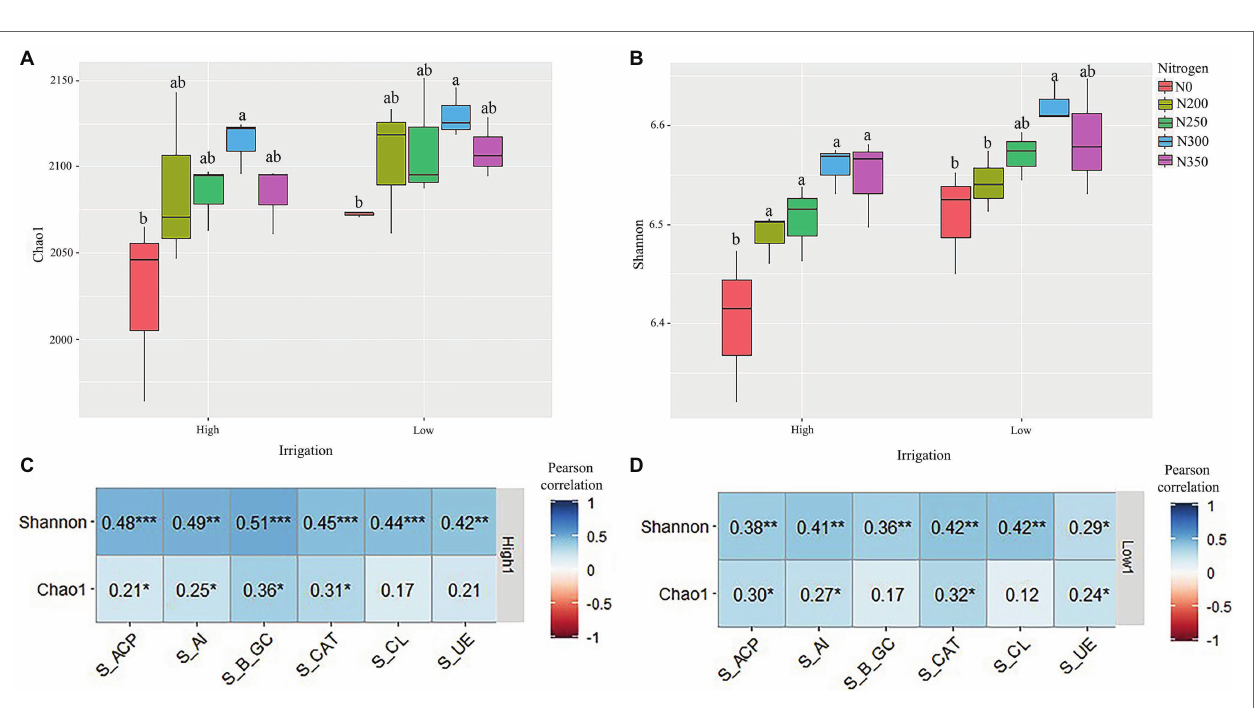
FIGURE 1 | (A,B) Bacterial alpha diversity indices represented by richness (a), and Shannon diversity (b) in each soil compartment and variety. (C,D) The correlation between indices of bacterial alpha diversity in high irrigation (C) and low irrigation (D) and environmental factors using Pearson correlation